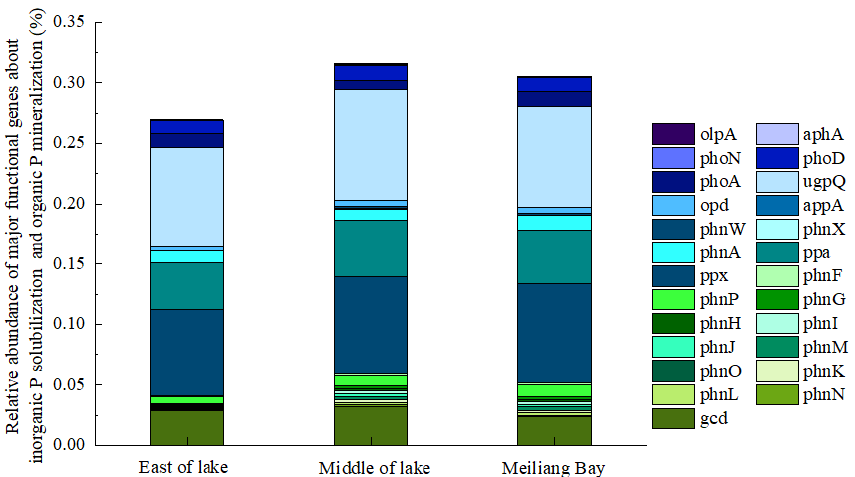
Figure 7. Major functional genes about inorganic P solubilization and organic P mineralization in surface sediments of Taihu Lake.